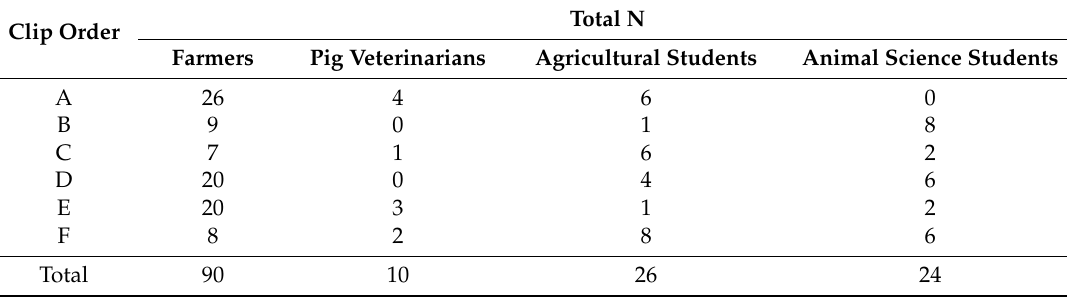
Table 5. Total number of participants who watched each of the six clip